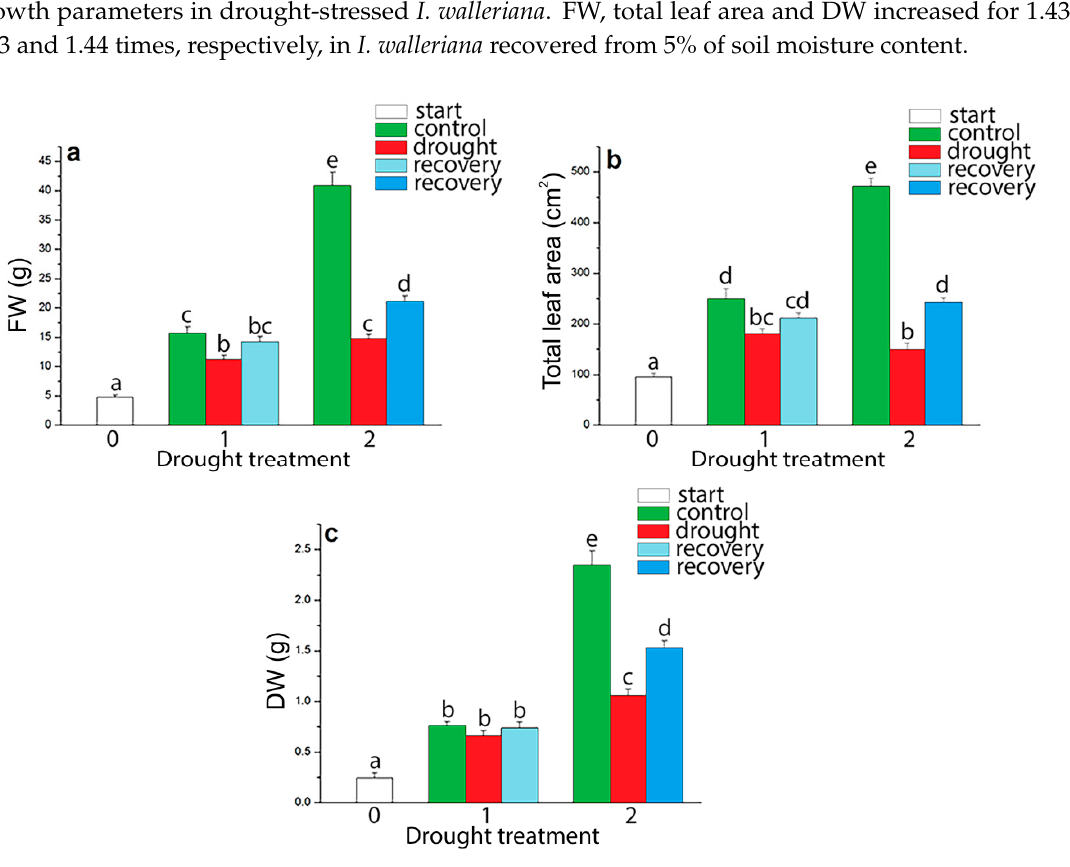
Figure 2. Growth parameters in drought-stressed I. walleriana grown ex vitro: Changes in shoots fresh weight (FW) ( a ), total leaf area ( b ) and shoots dry weight (DW) ( c ) were examined at the “start point”, 15% and 5% of soil moisture content—0, 1 and 2, respectively; results represent mean ± SE ( n = 8). The letters indicate statistically significant differences based on the Fischer LSD test ( p ≤ 0.05).